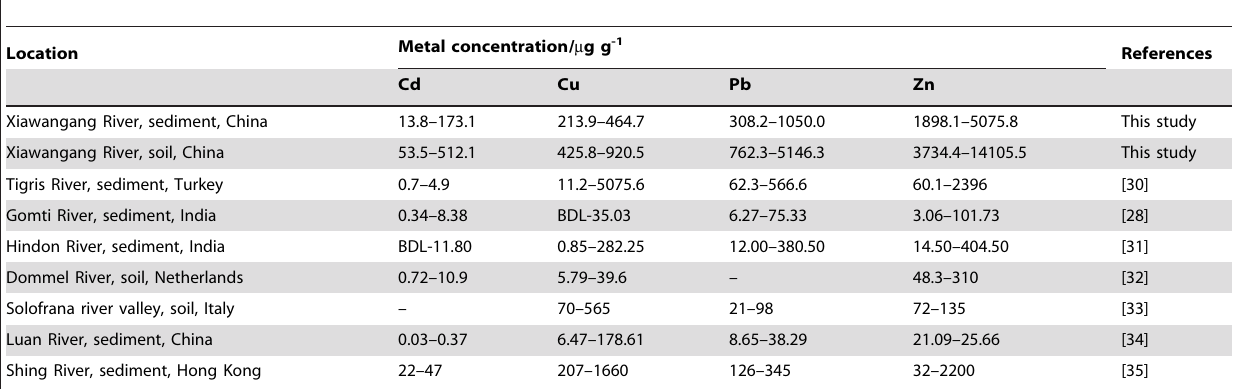
Table 4. Comparison the metal concentrations of Xiawangang River with the other rivers (BDL is below detection limit).